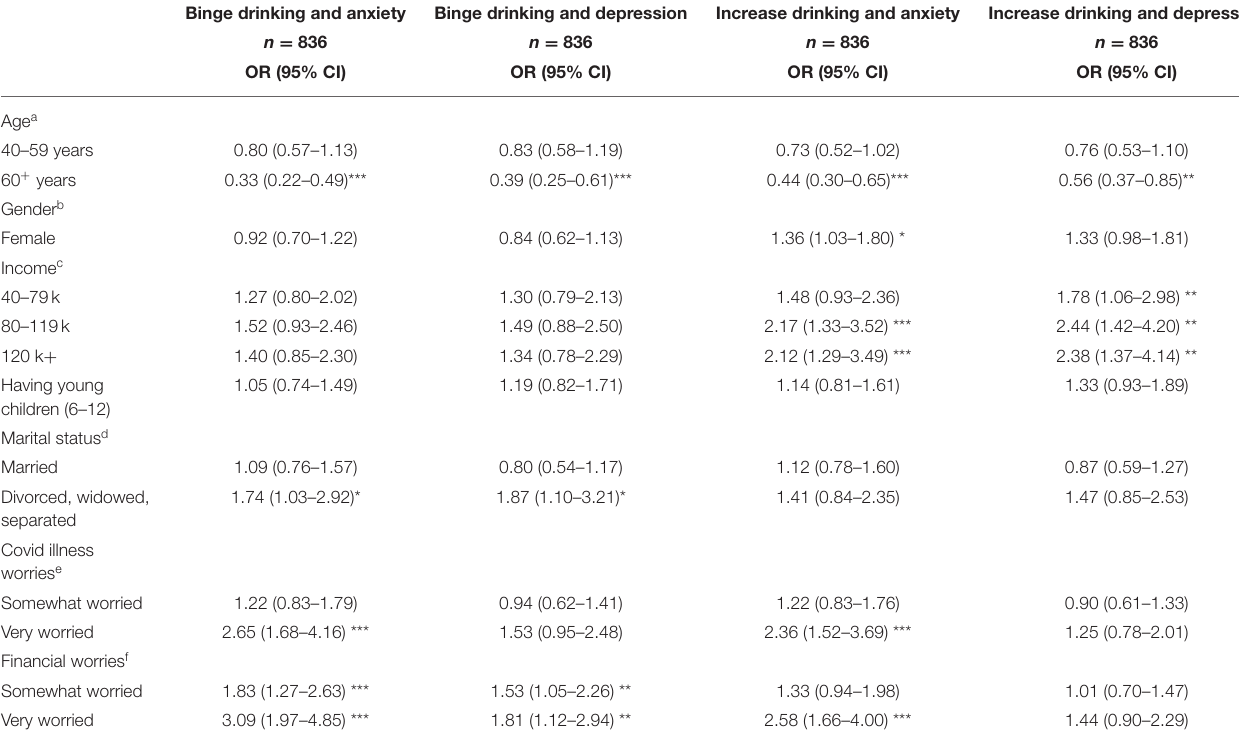
TABLE 3 | Multivariate analysis for the associations between all predictor variables and binge drinking and anxiety; binge drinking and depression; increase drinking and anxiety; and increase drinking and depression. Binge drinking and